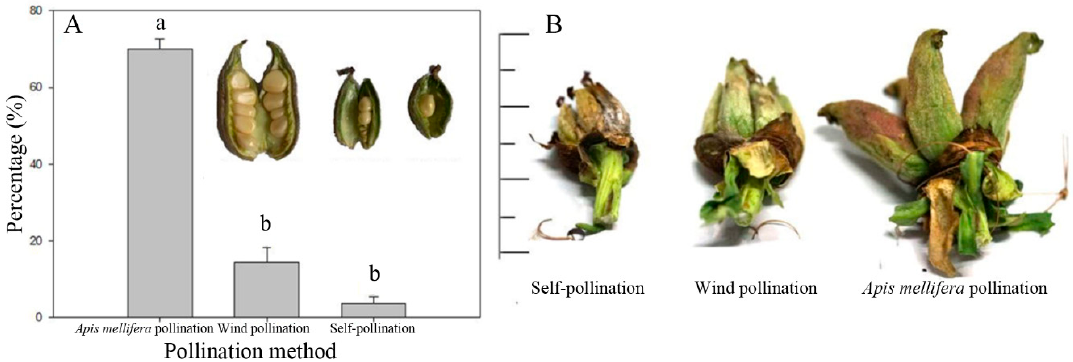
Figure 5. Seed set of the oil tree peony ‘Feng Dan’ treated with different pollination methods ( A ) and clustering follicles of the oil tree peony ( B ). Notes: Data in the figure are presented as the mean ± standard error. Different letters above the columns in the figure indicate a significant difference at the 5% level (one-way ANOVA).